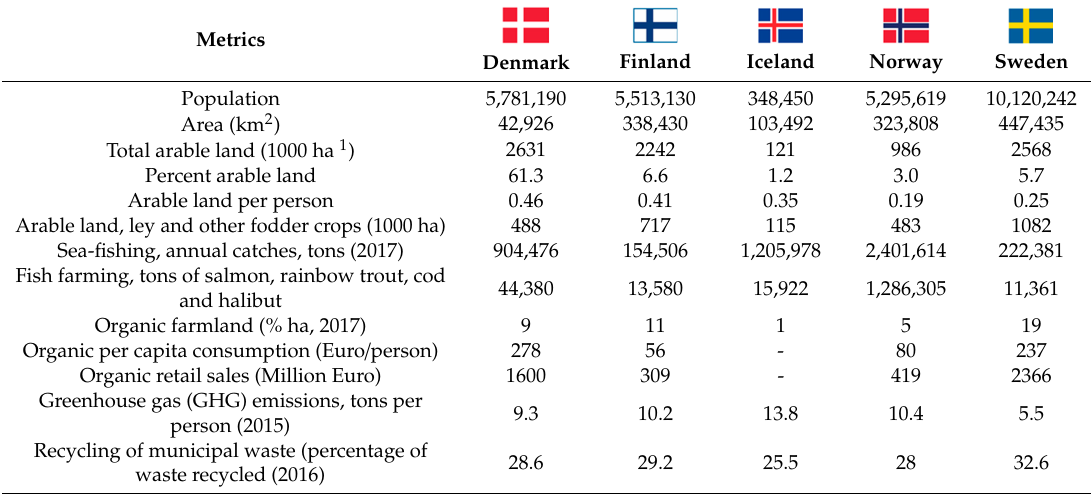
Table 3. Background statistics for the five Nordic countries